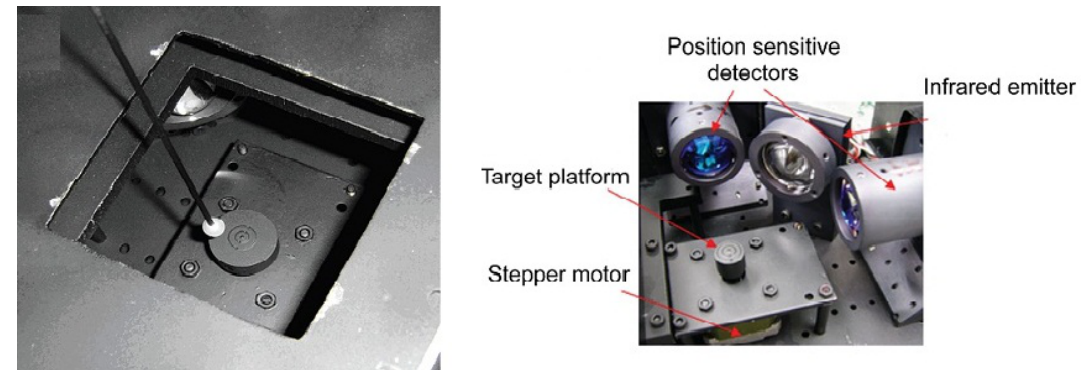
Figure 1. Micro Motion Sensing System (M 2 S 2 )